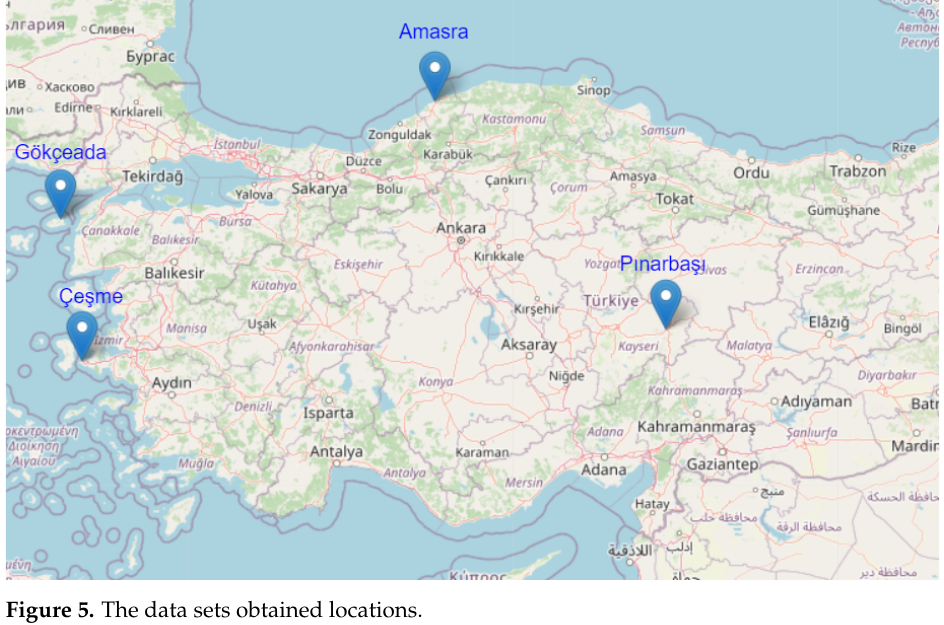
Figure 5. The data sets obtained locations.